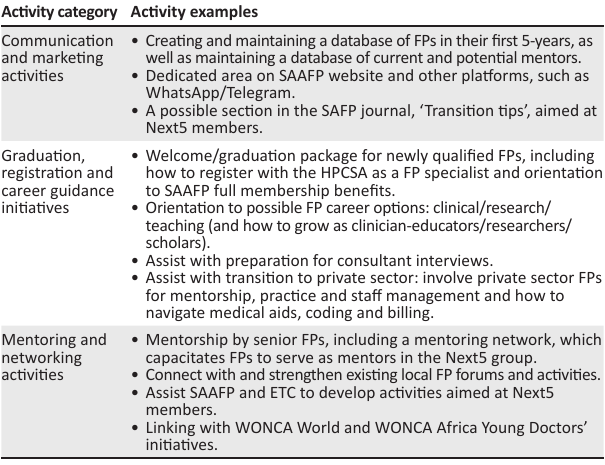
TABLE 1: Activity suggestions for the Next5 special interest group as informed by the membership survey. Activity category Activity examples Communication and marketing activities